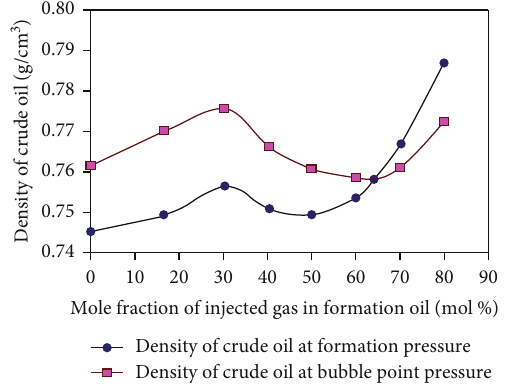
volume. 2 Figure 7: Curves of composition of well fl uid.